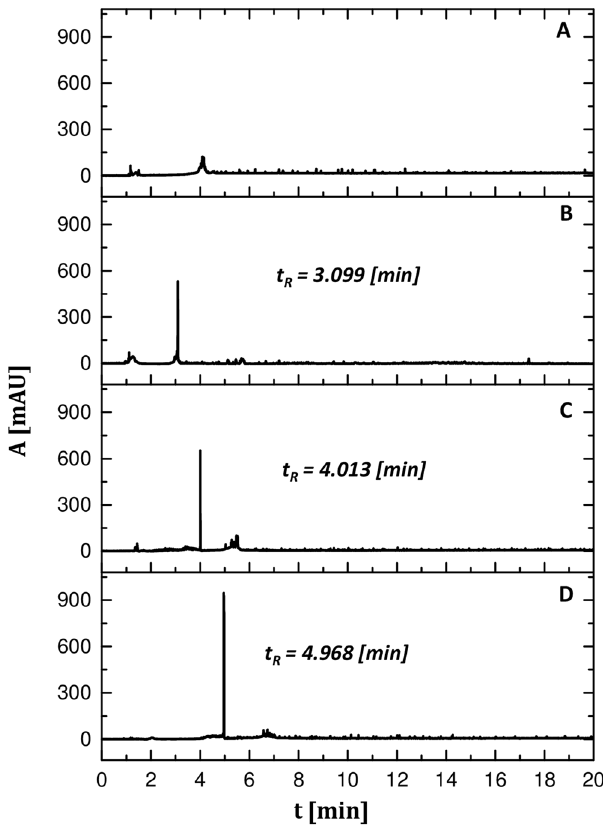
Figure 3. Electropherogram of non-modified S . cerevisiae ( A ); modified S . cerevisiae by 5 mM Ca(NO 3 ) 2 at pH = 6 ( B ), pH = 8 ( C ) and pH = 9 ( D ). Conditions: inlet buffer: TBH (pH = 7.31), outlet buffer: TB (pH = 7.98), suspensive buffer: TB (pH = 7.98); I = 100 μ A, U = 15 kV, t = 23 °C, λ = 214 nm, L = 33.5 cm, L eff = 25 cm, φ = 100 μ m, injection: 20 mbar t = 8